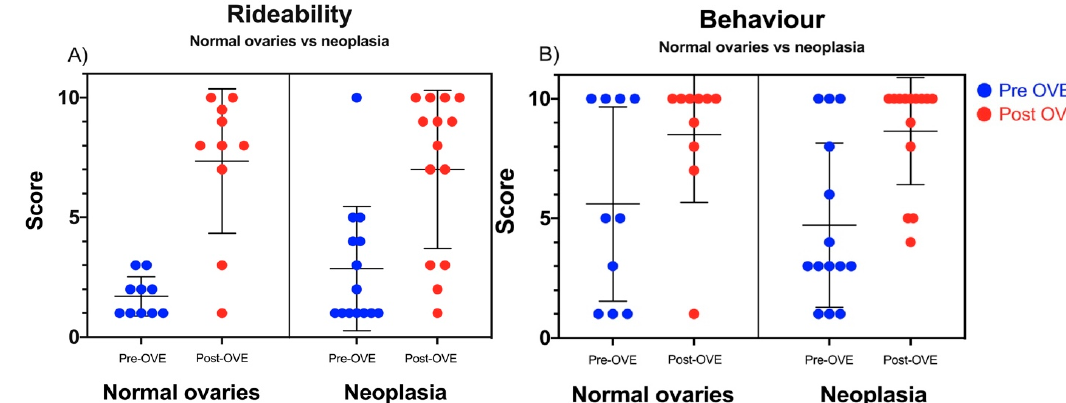
Figure 2. Comparison of ( A ) rideability and ( B ) behaviour pre- and post–ovariectomy (OVE) in mares with histologically normal ovaries and neoplasia. The scores on the y -axis indicate the owners’ observations. Horizontal markers indicate the mean value and standard deviation. (1–10, with 10 being optimal rideability/behaviour). Both rideability and behaviour were significantly improved following OVE, however no difference was noted when comparing horses with or without ovarian neoplasia.